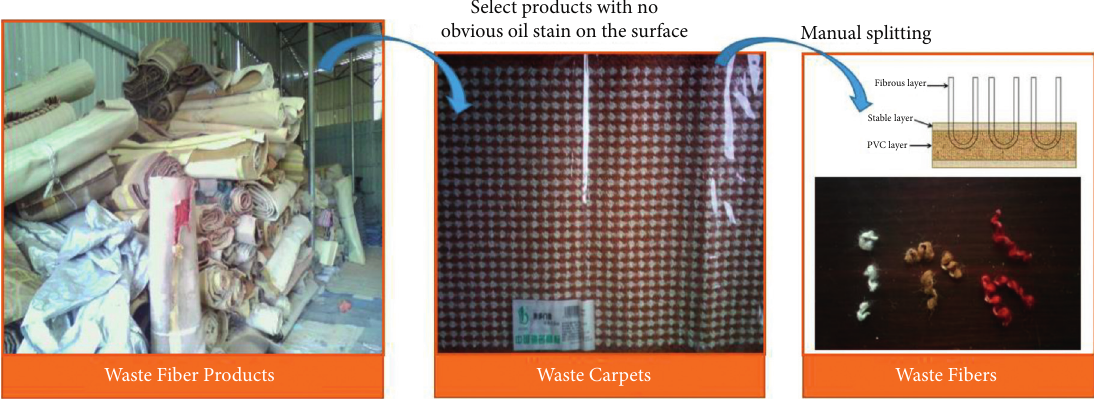
Figure 2: The preparation of waste